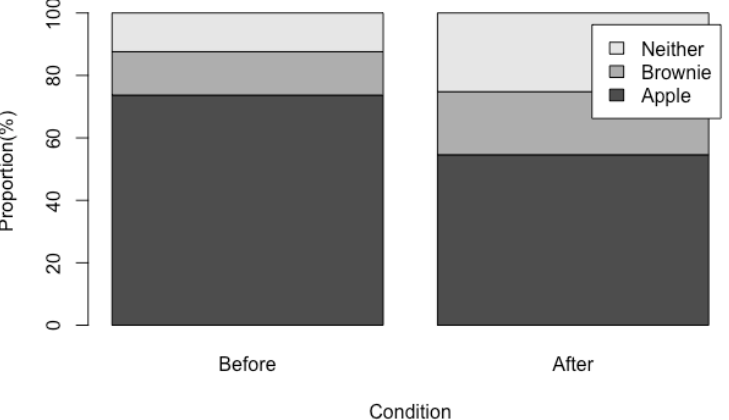
Figure 1. Proportion of snack choices (apple, brownie, or neither) for consumption after completion of a workout chosen either before the beginning of the workout (“before” condition) or after completion of the workout (“after” condition).